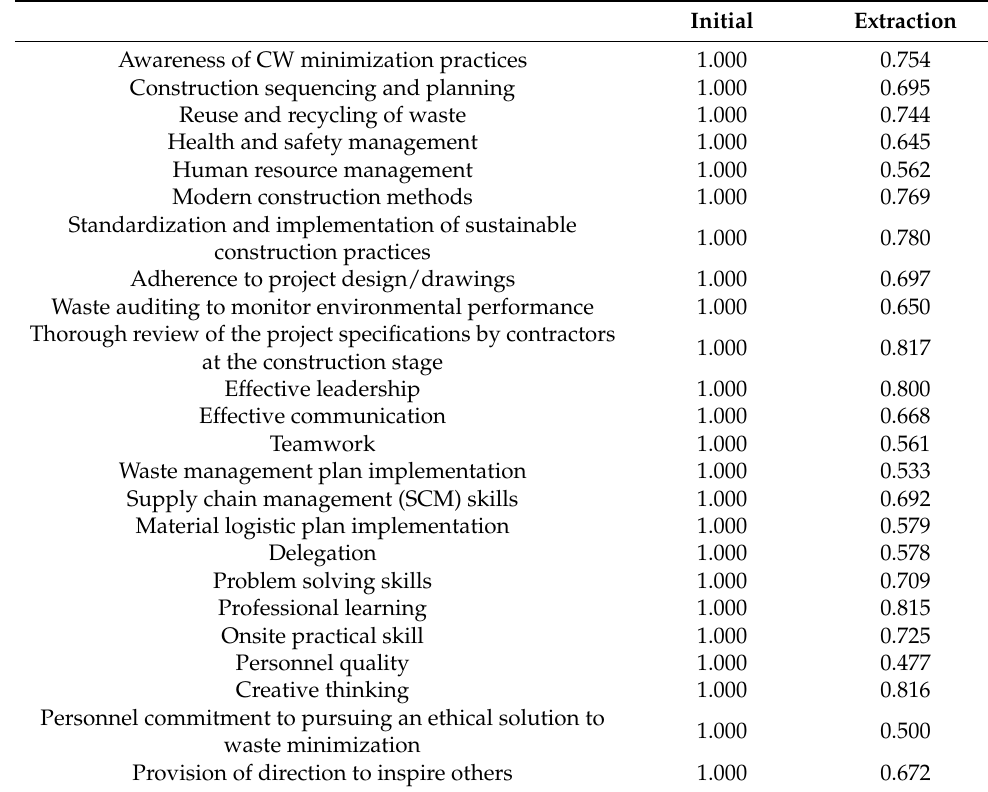
Table 3. Communalities for Key Competencies that Drive Material Waste Minimization at the Construction Stage of